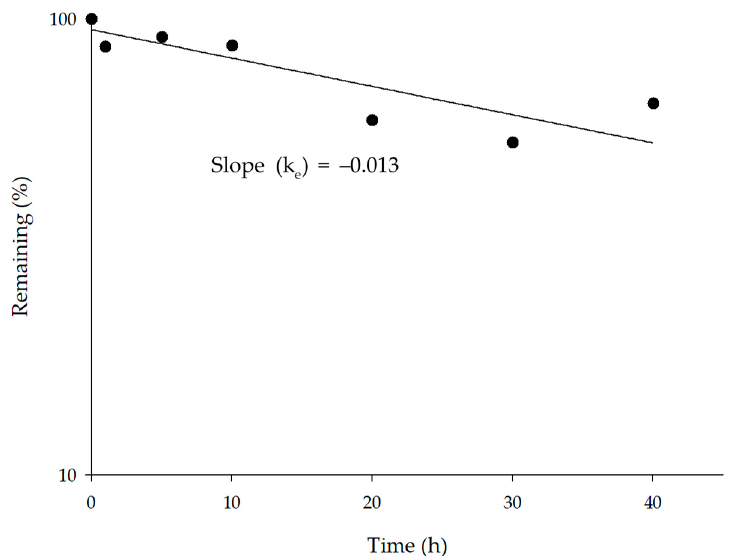
Figure 2. The plot of remaining rate of O -desmethyltramadol (M1) after incubation with human liver microsoms (HLM). Each point (obtained by duplicate measurements) represents the mean value. The intrinsic clearance by HLM (CL int,mic ) was calculated as 52.92 μ L/min/mg protein.